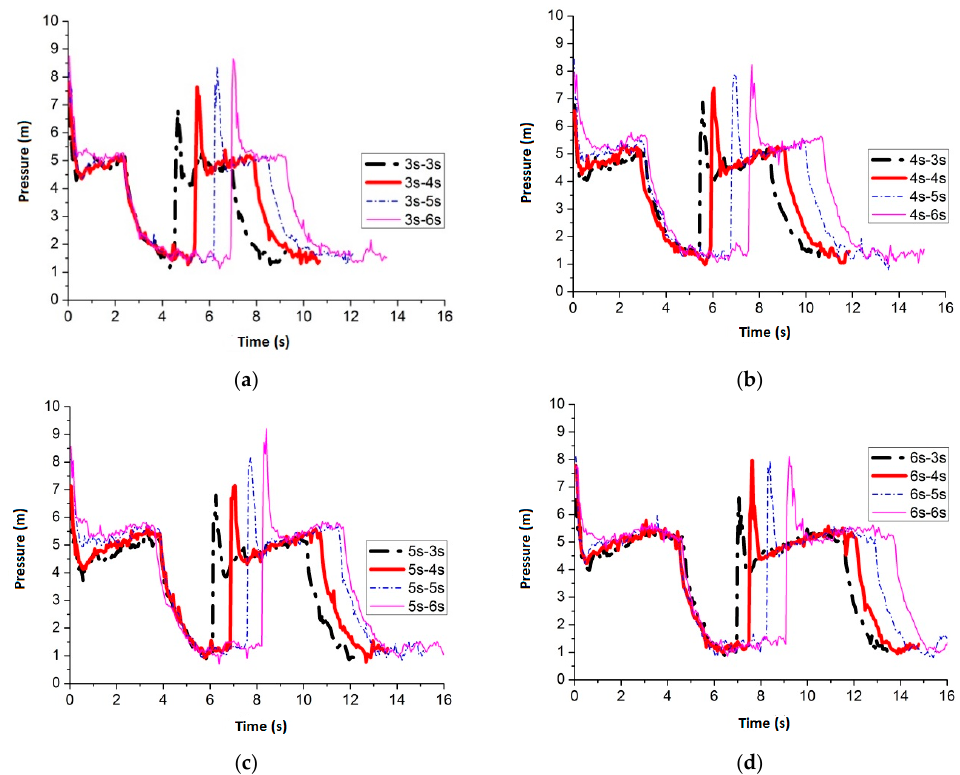
Figure 3. Pressure fluctuation of No. 1 sensing point (round nozzle is in the middle of the pipe): ( a ) air inflow time is 3 s; ( b ) air inflow time is 4 s; ( c ) air inflow time is 5 s; and ( d ) air inflow time is 6 s.